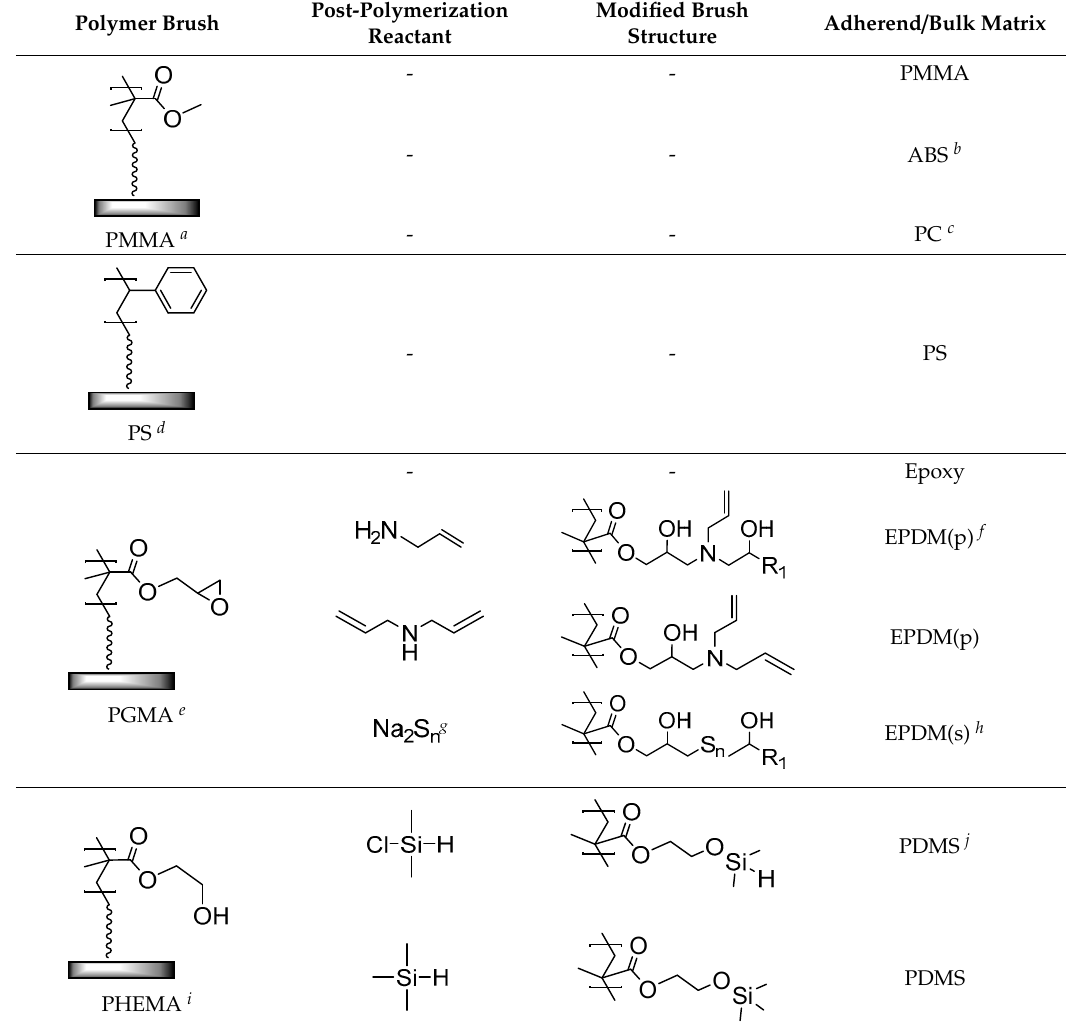
Table 2. Various material combinations with bonding relying on the entanglement of polymer brushes into bulk polymers a